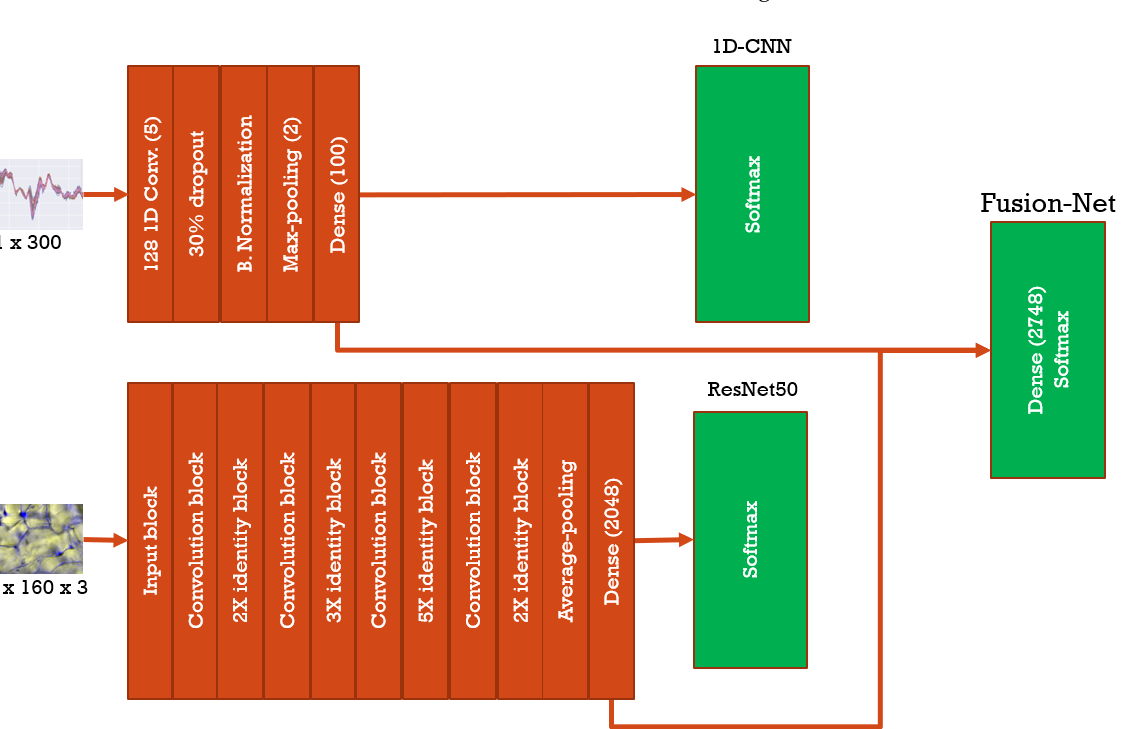
Figure 5. Architectures of 1D-CNN and Fusion-Net; Fusion-Net combined 1D-CNN on spectra and ResNet50 on custom three-band images with three channels of 530 nm, 680 nm band images, and its band ratio image.